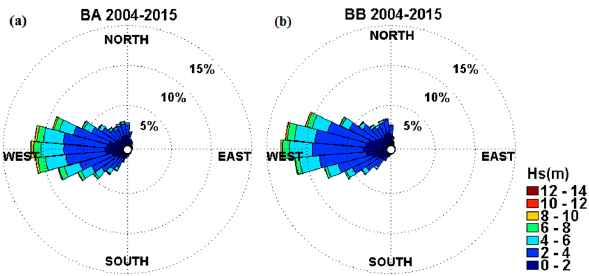
Figure 9. 12-year wave roses between H s and MWD at ( a ) BA and ( b ) BB.